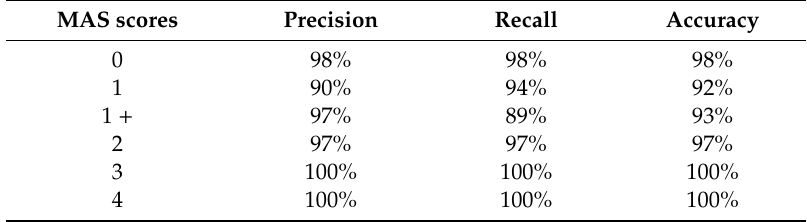
Table 8. Precision and recall of RF with FS2 derived from